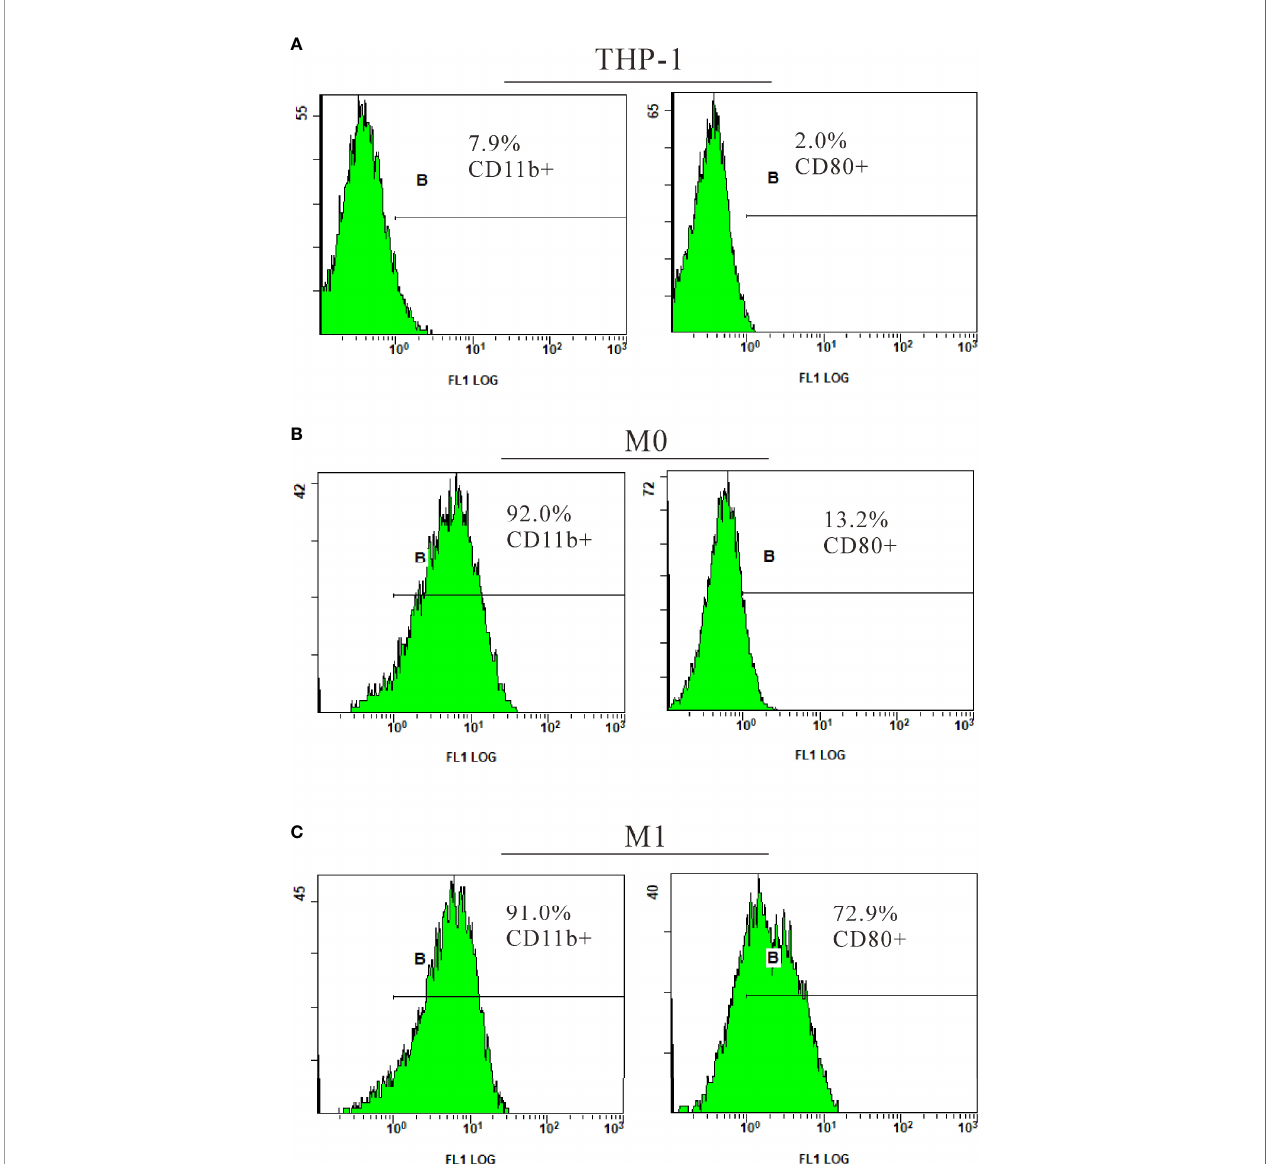
FIGURE 4 | Identi fi cation of M1 macrophages by fl ow cytometry. THP-1 cells were cultured with PMA (20 ng/ml) for 48 h to transform into M0. After culture without PMA for 24 h, the M0 macrophages were treated with LPS (1 µg/ml) for 24 h to induce M1. CD11b, a surface marker of macrophages; CD80, a surface marker of M1 macrophages; PMA, phorbol-12-myristate-13-acetate; LPS, lipopolysaccharide; M0, undifferentiated macrophage; M1, M1